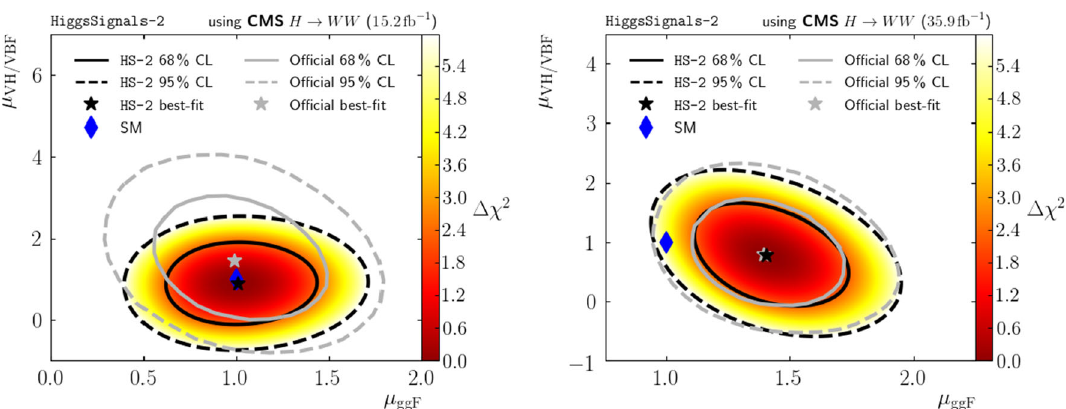
Fig. 10 Comparison of the reconstructed fit results for the signal strength modifiers for fermionic ( μ ggF ) and bosonic ( μ VH / VBF ) pro- duction modes with the official results for different CMS analyses in the H → WW decay channel at 15 . 2 fb − 1 [59] (left panel) and